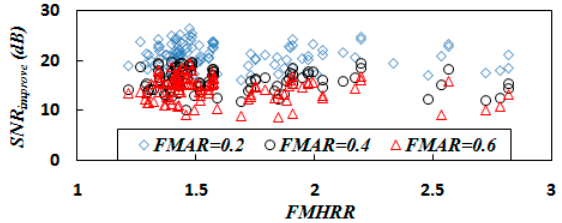
Figure 9. The change of SNR improvement with the FECG and MECG heart rate ratio (FMHRR) when FNR is fixed.